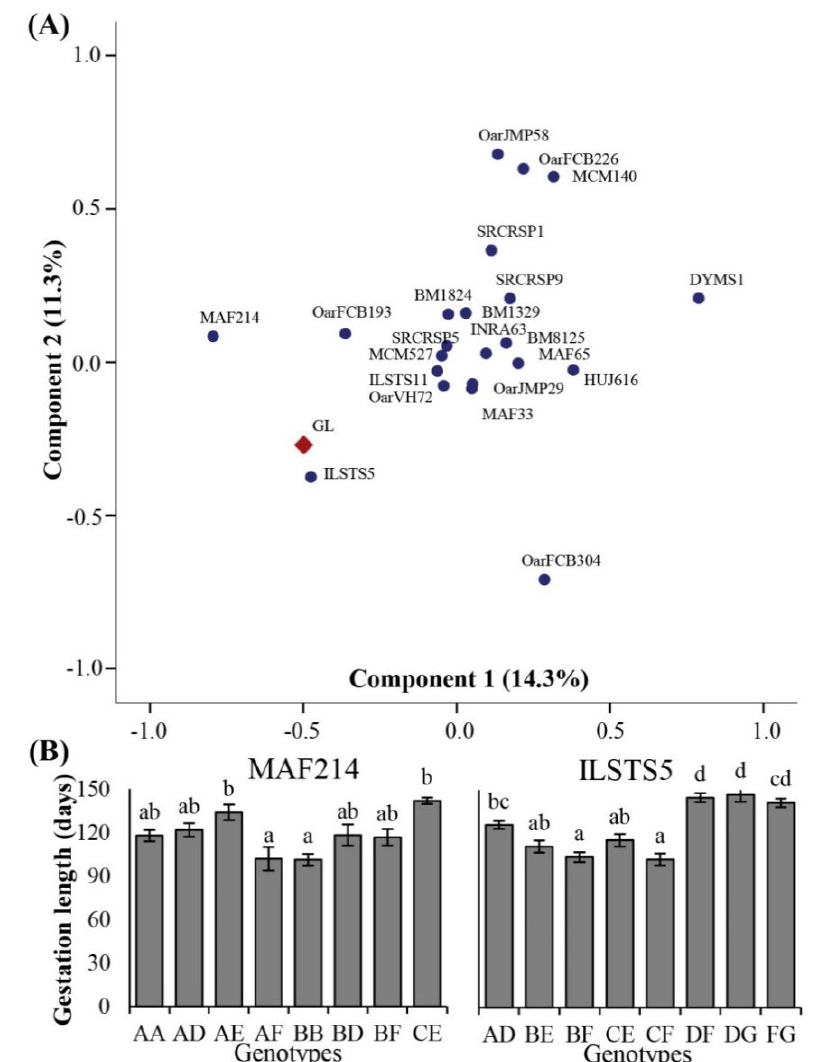
Figure 2. Association analysis between microsatellite loci and gestation length in Kari sheep. ( A ) Principal component plot showing clustering of closely associated parameters. ( B ) Mean gestation length among different genotypes of highly correlated loci. Labels on the bars (letters a–d) show a comparison among genotypes ( p < 0.05).